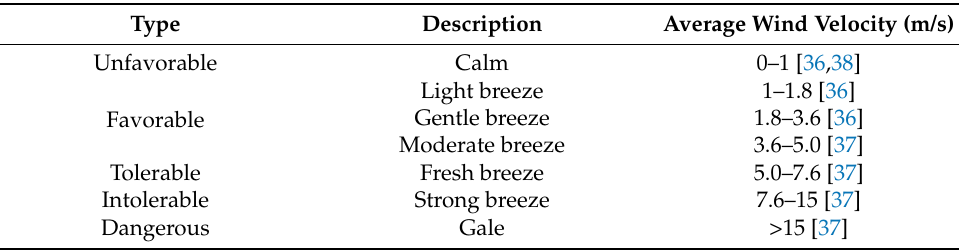
Table 1. Summer low wind comfort criteria in terms of the average wind velocity.